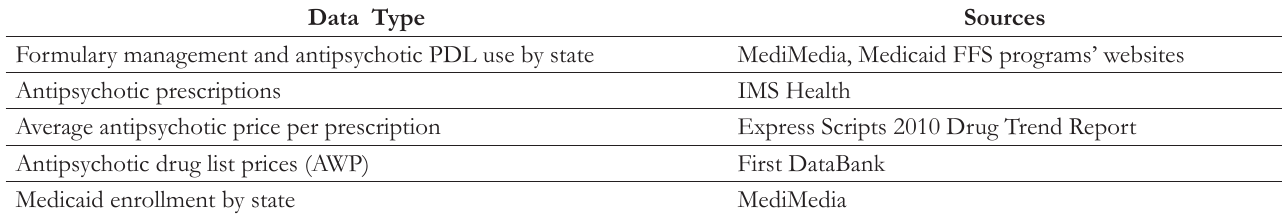
Table 1. Data Types and